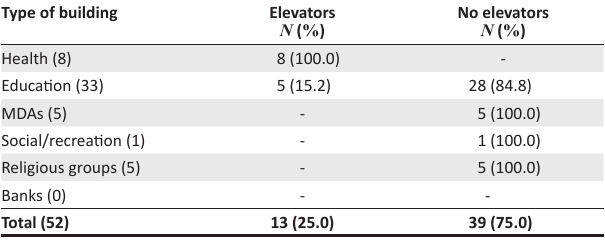
TABLE 3: Distribution of buildings with more than one storey fitted with elevators. Type of building